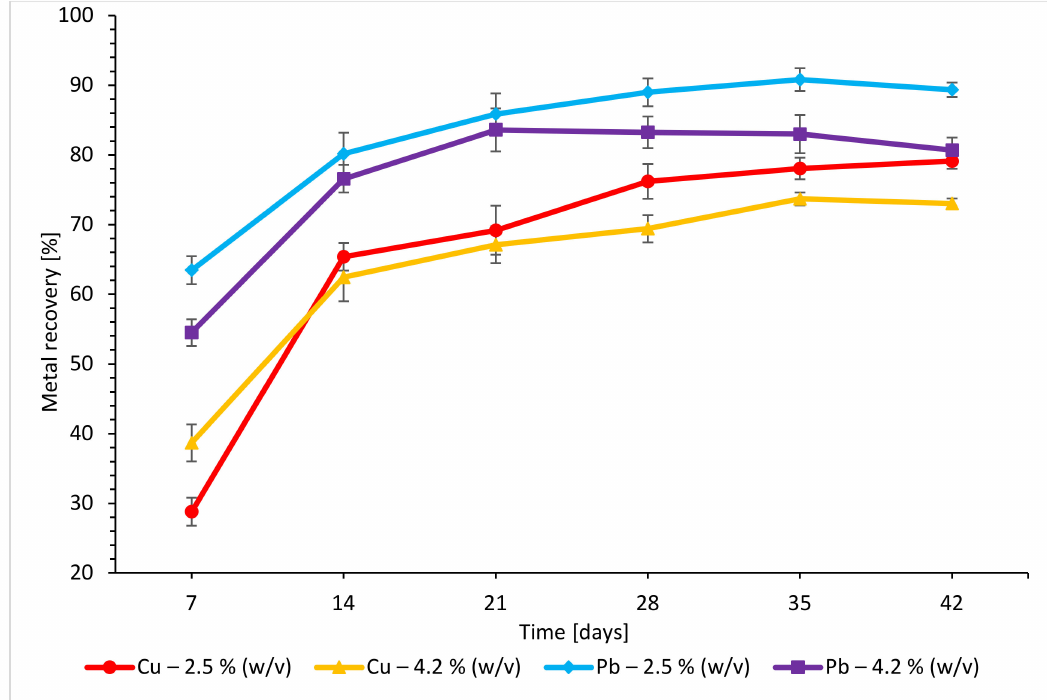
Figure 16. Influence of pulp density on Cu and Pb recovery (pH 2, stirring speed 100 rpm, and particle size < 40–200 µ